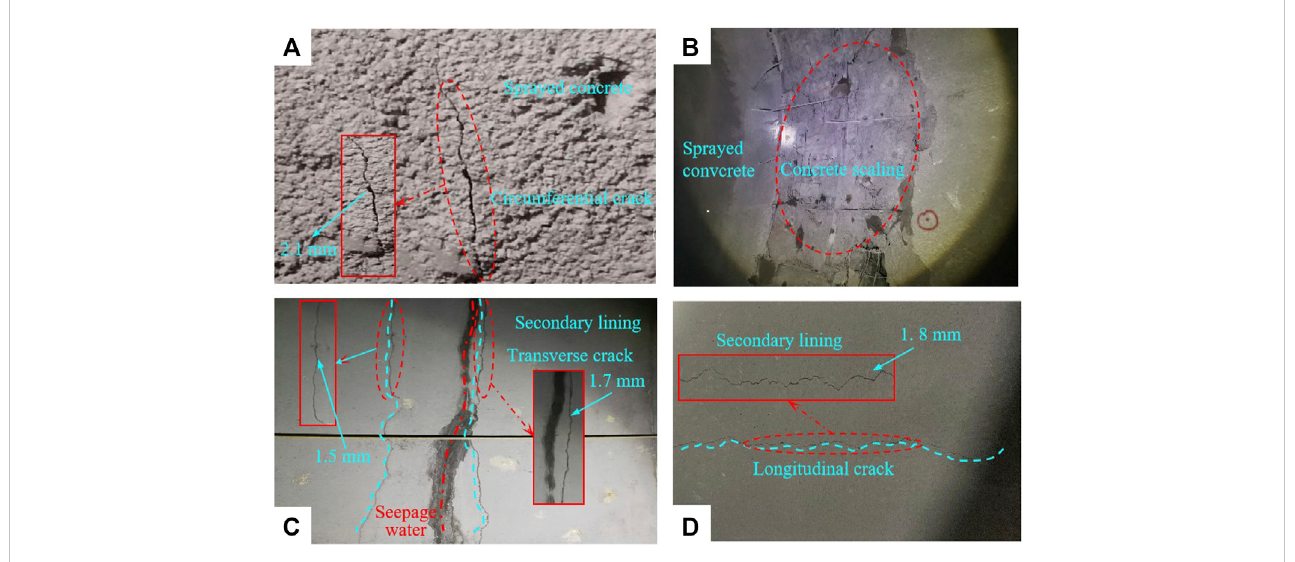
FIGURE 2 Cracking on-site of (A,B) primary supports and (C,D) secondary